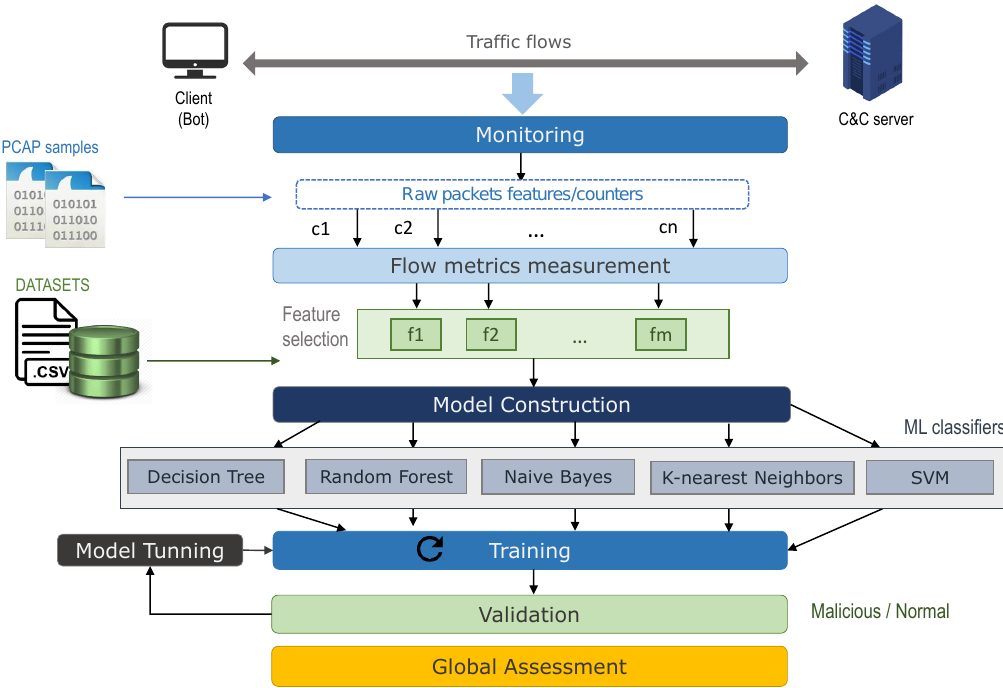
Figure 1. Communication scheme for metrics selection and model